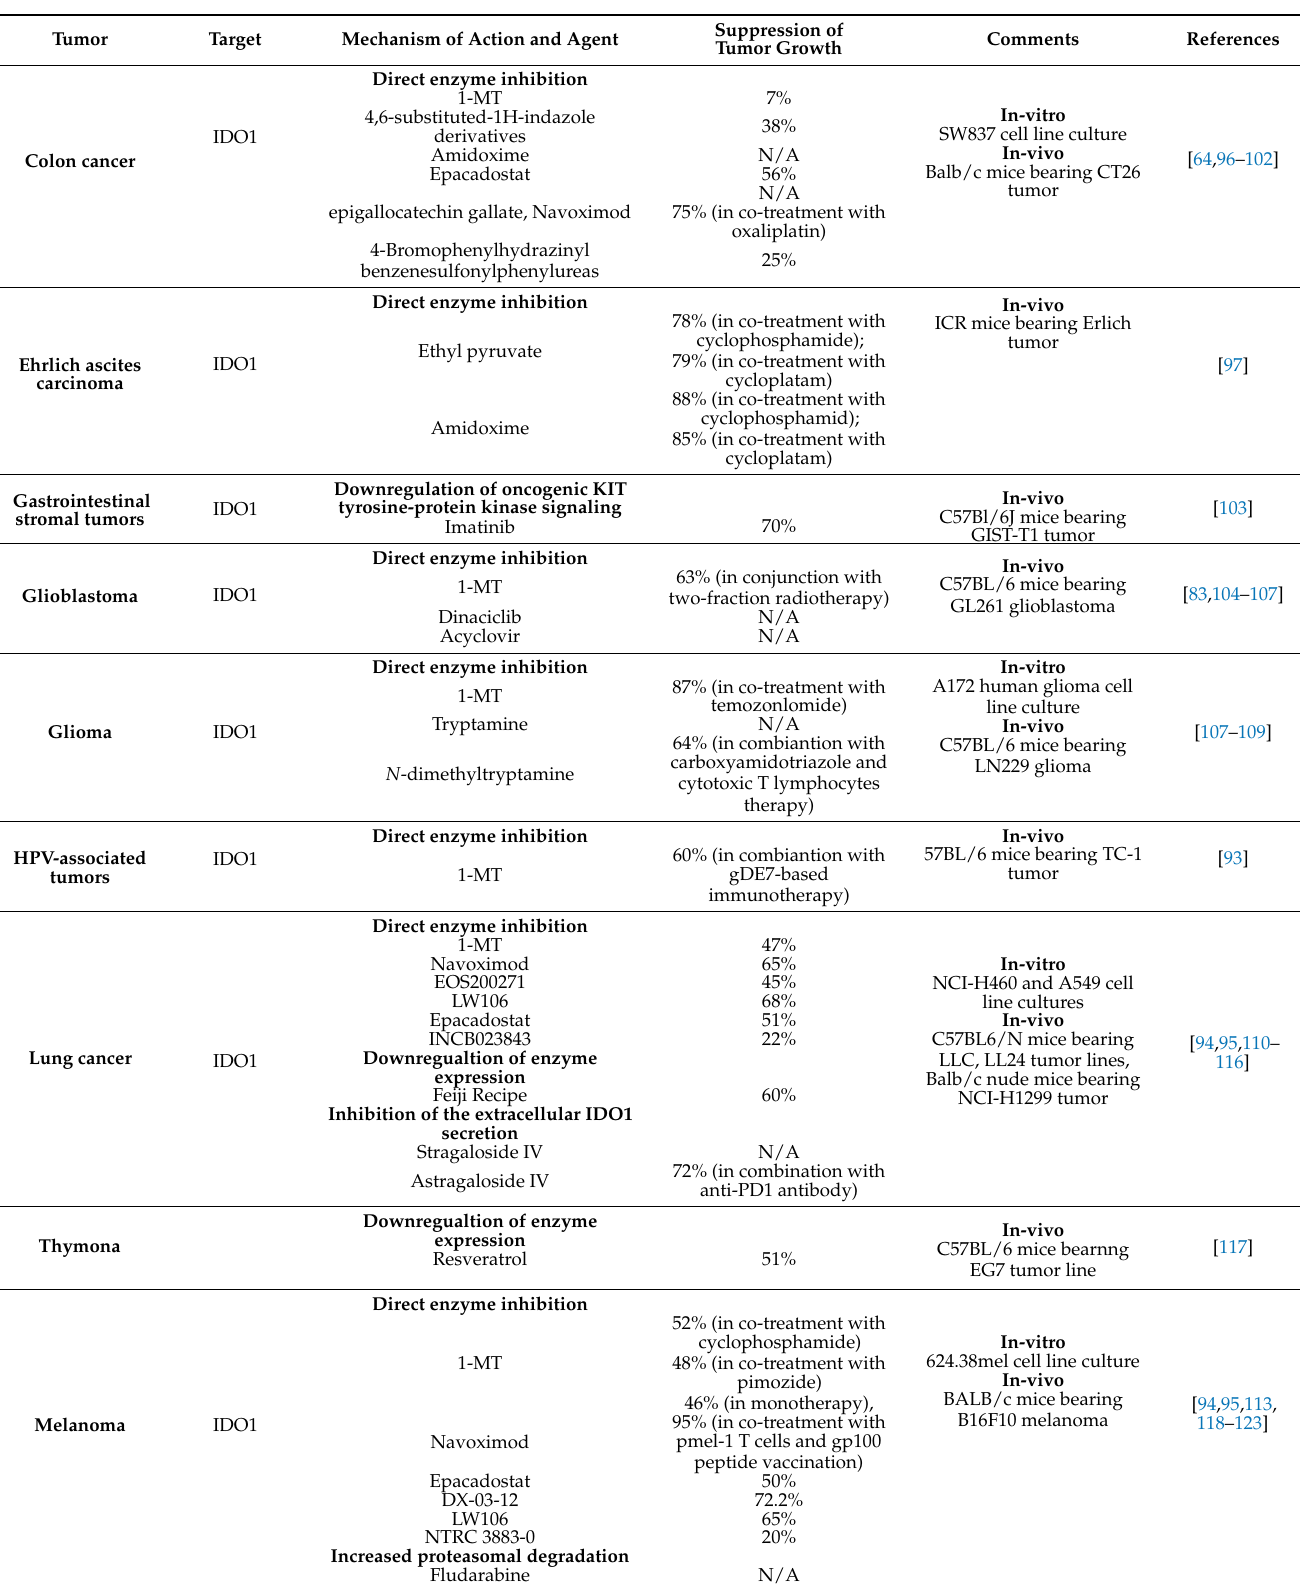
Table 1. Targeting KP enzymes in preclinical studies on antineoplastic